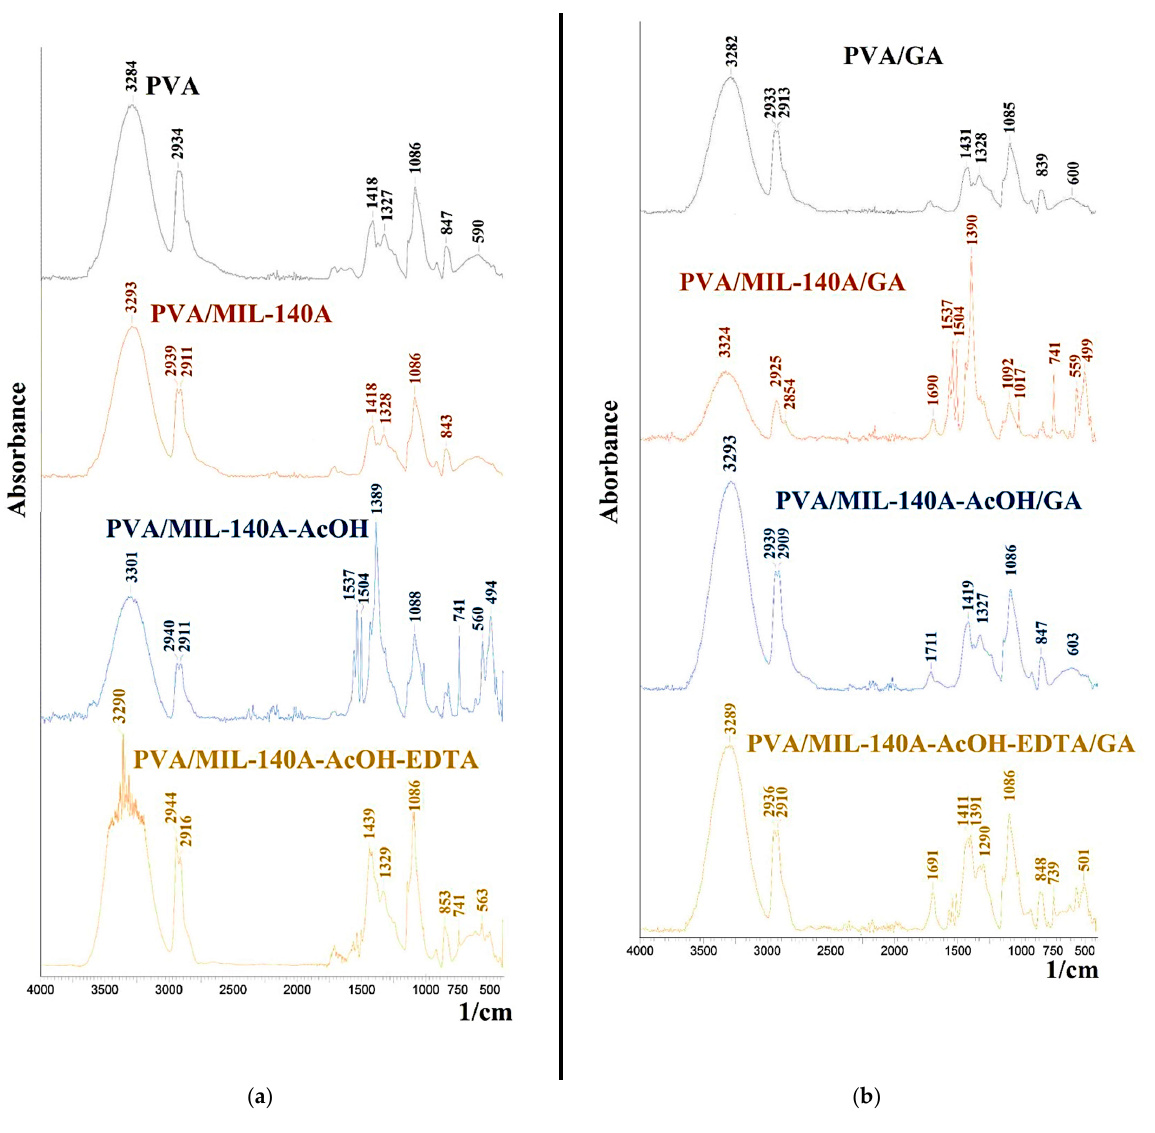
Figure 4. FTIR spectra of ( a ) the uncross-linked and ( b ) cross-linked PVA and PVA/Zr-MOFs(10%) membranes.